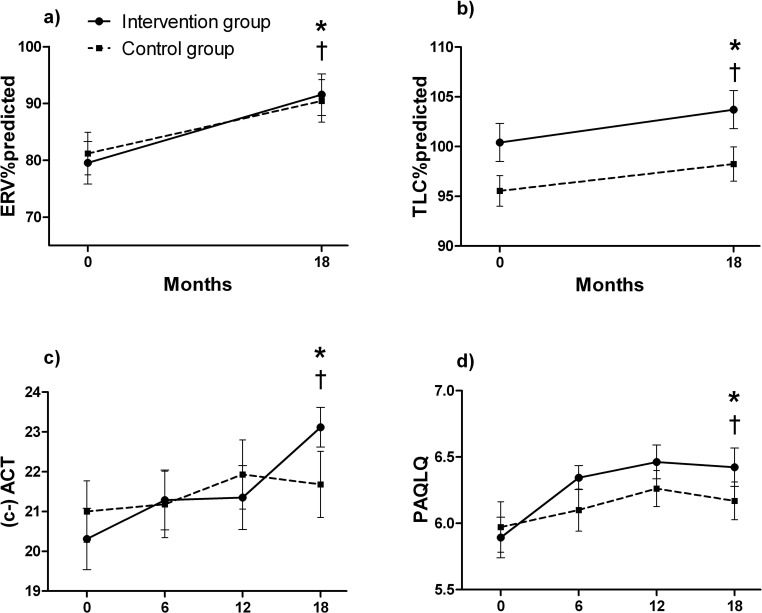
Changes over time in: a) ERV%predicted, b) TLC%predicted, c) (c)- ACT ll, d) PAQLQ ll §. Data are presented as mean (SEM). *: Significant difference over time in the intervention group (p<0.05). †: Significant difference over time in the control group (p<0.05). ‡: Significant difference between intervention and control group over time (p<0.05). §: Intention to treat analyses are presented. ll: Only subjects with an asthma diagnosis are shown. Abbreviations: (c)-ACT: (childhood) asthma control test (score can range between 0 = not well controlled to 27 = well controlled asthma), ERV%predicted: expiratory reserve volume in % predicted, PAQLQ, paediatric asthma quality of life questionnaire (with 23 questions in three domains (symptoms, activity limitation and emotional function), all questions can be scored on a 7-point scale (7 = not bothered at all—1 = extremely bothered). The overall PAQLQ score is the mean of all 23 responses.), TLC%predicted: total lung capacity in % predicted.